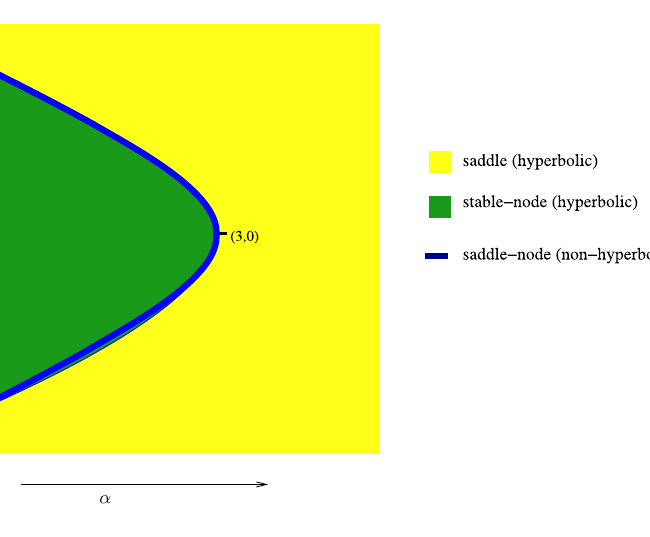
Fig. 11 Bifurcation diagram from Table 7 for P 3 and P 4 varying parameters α and λ